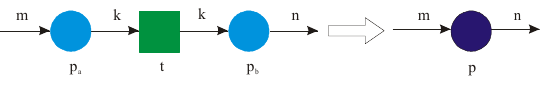
Fig.9. Sequence places reduction rule